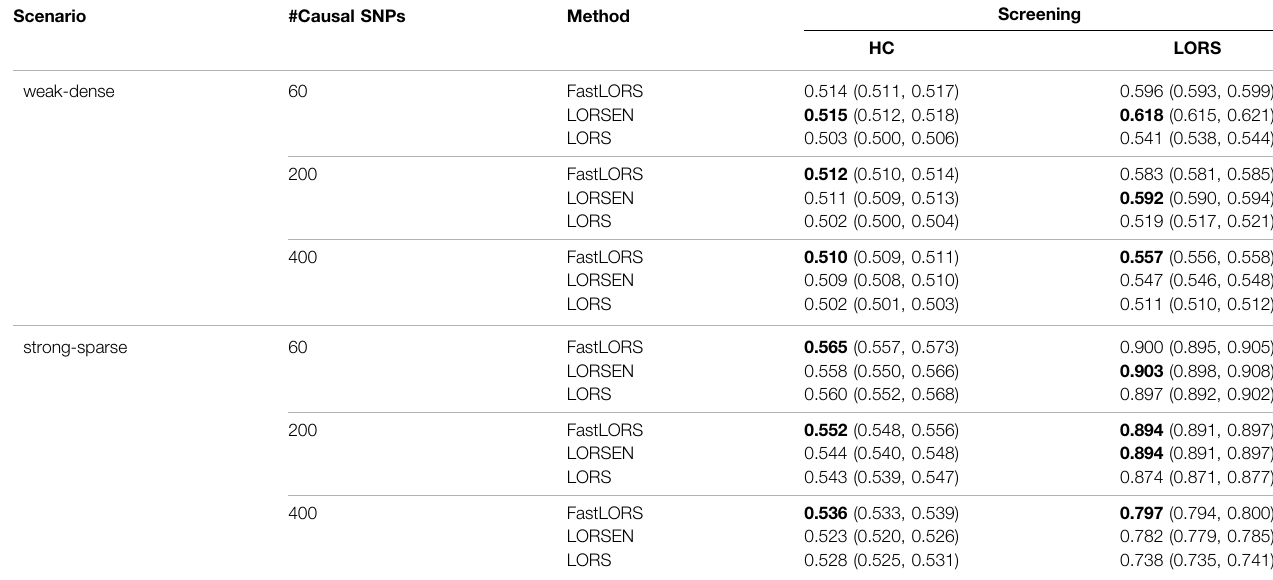
TABLE 5 | The average AUC and 95% con fi dence interval with the SNP screening with ten replicates for each simulation scenario. SNPs are only from chromosome 1. For each simulation scenario, the highest AUC is in